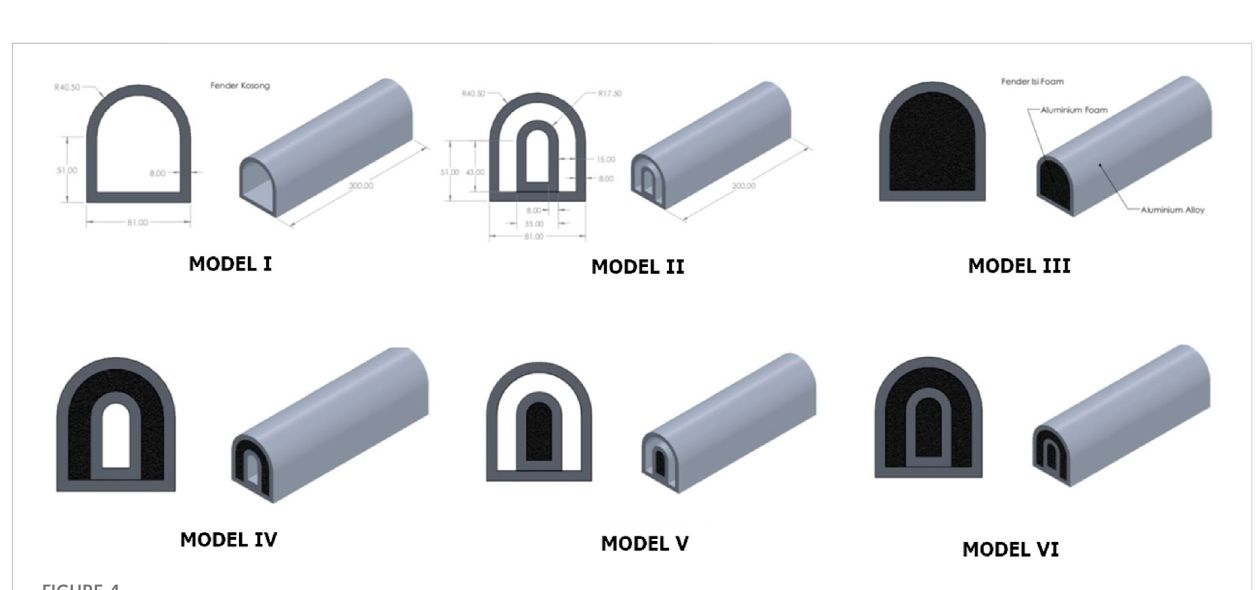
FIGURE 4 The Finite Element (FE) for 6 models of fender structure.